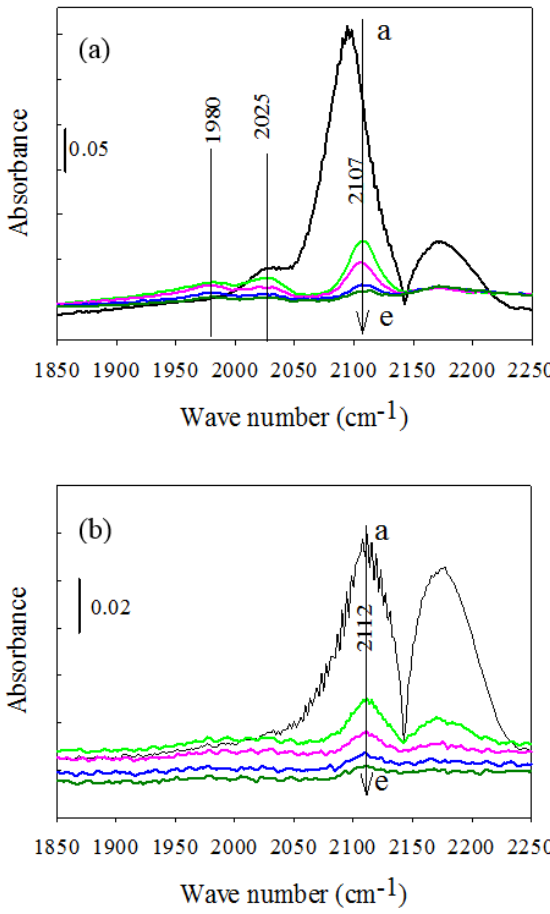
Figure 4. CO-DRIFT spectra of Au/La 2 O 3 /Al 2 O 3 catalysts: ( a ) Au/La 2 O 3 /Al 2 O 3 (H); ( b ) Au/La 2 O 3 /Al 2 O 3 (S35). Lines a to e correspond to spectra recorded after CO adsorption at 80 °C and subsequent He purge for 3, 5, 10, 20, and 30 min, respectively. CO-DRIFT: diffuse-reflectance infrared Fourier-transform spectroscopy after CO adsorption